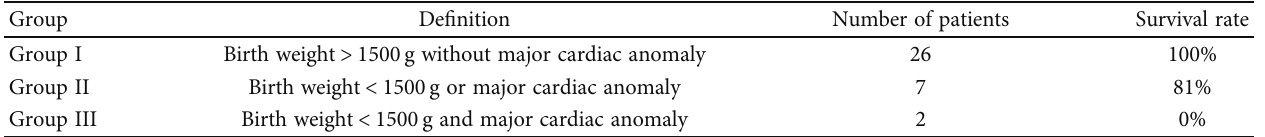
Table 6: Survival rate of patients in relation to Spitz risk classi fi